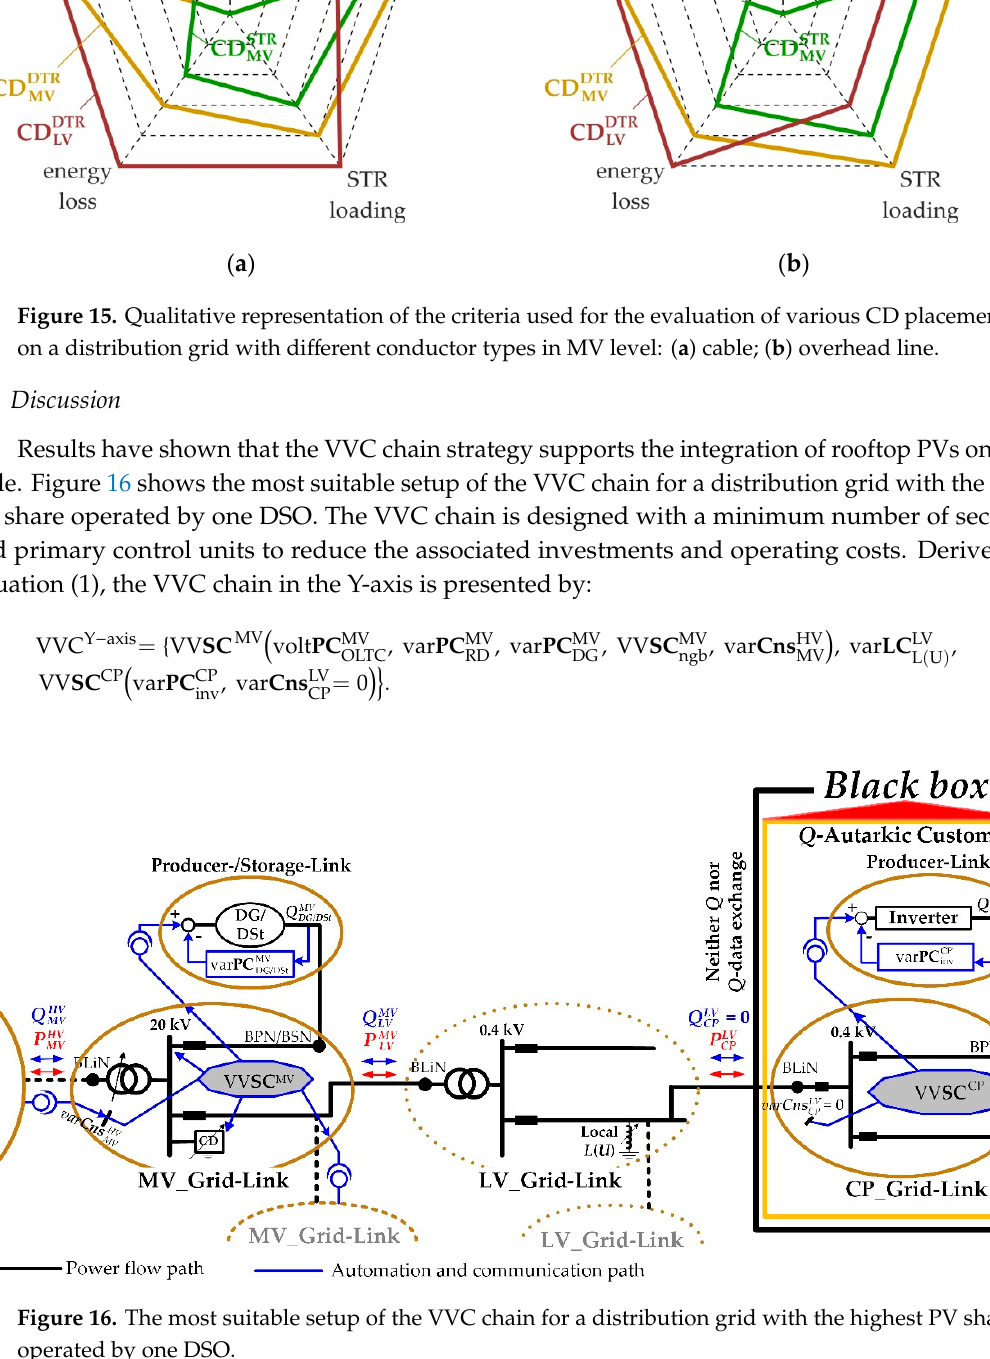
on a distribution grid with different conductor types in MV level: ( a ) cable; ( b ) overhead line.